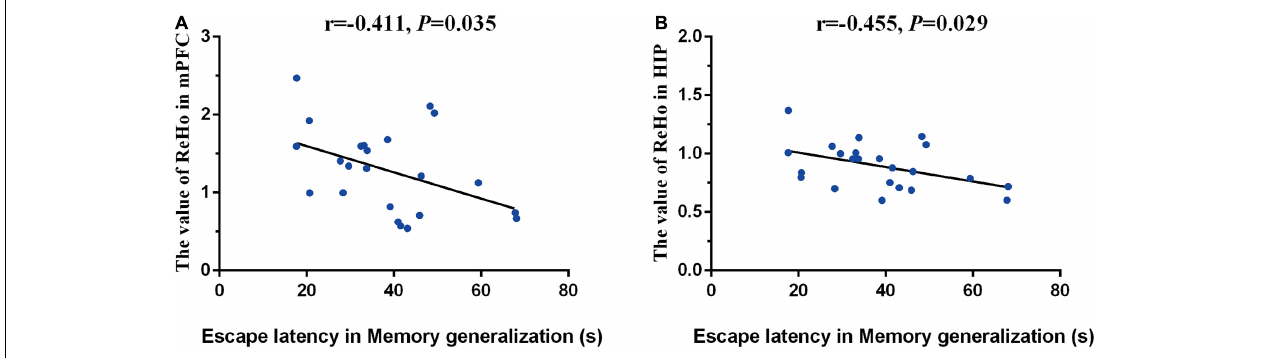
FIGURE 5 | Correlations between functional activity and memory generalization ability. (A) Correlation between the functional activity of mPFC and memory generalization ability. (B) Correlation between the functional activity of hippocampus and memory generalization ability.